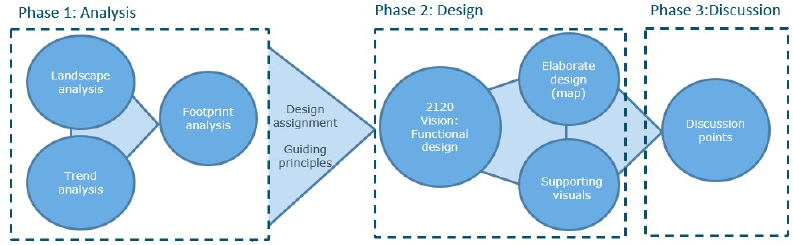
Figure 3. Setup of the Arnhem case.